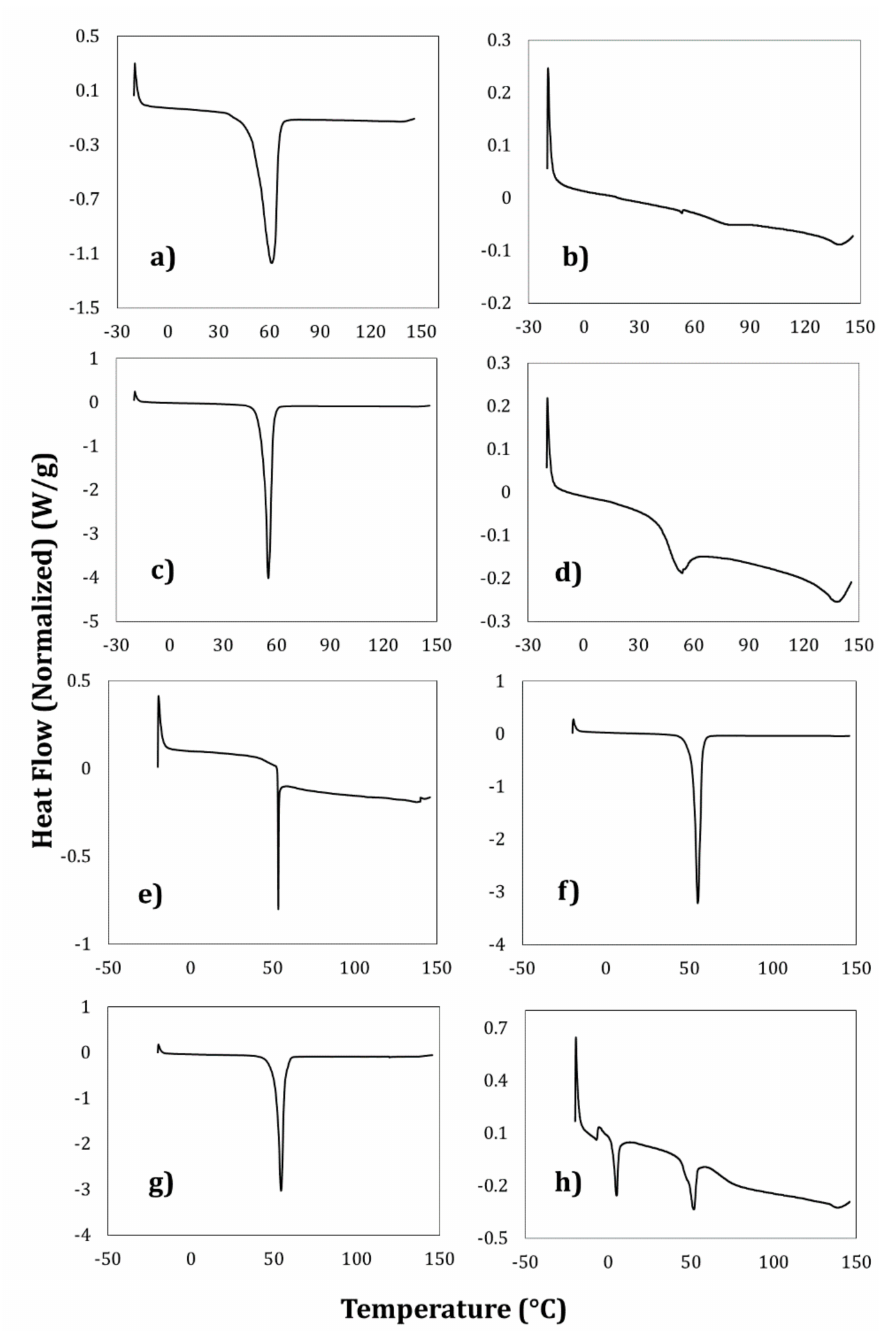
Figure 5. Di ff erential scanning calorimetry for the encapsulating ( a ) poly- ε -caprolactone and ( b ) ethyl cellulose polymers, and the stabilizing polymers ( c ) Pluronic ® F-127 and ( d ) PVA used to form the polymeric nanocapsules: ( e ) ETC-PVA; ( f ) ETC-Pluronic ® F-127, ( g ) PCL-Pluronic ® F-127 and ( h )